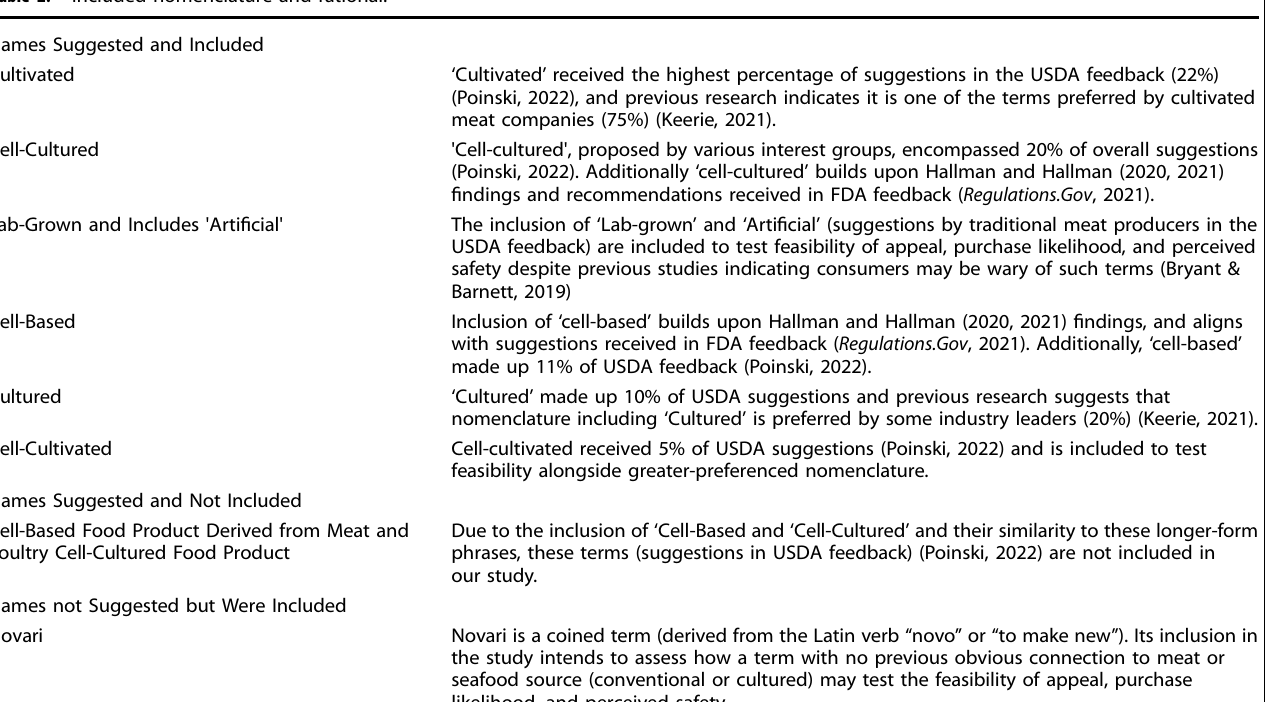
Table 2. Included nomenclature and